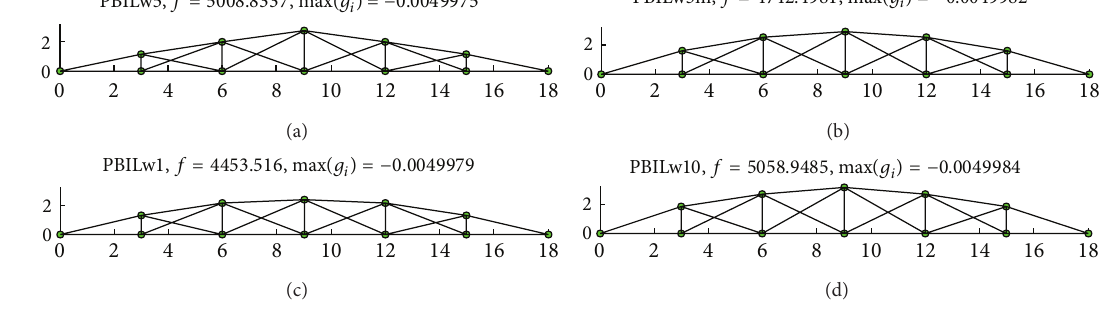
Figure 9: Optimum structures of AOP5 from various